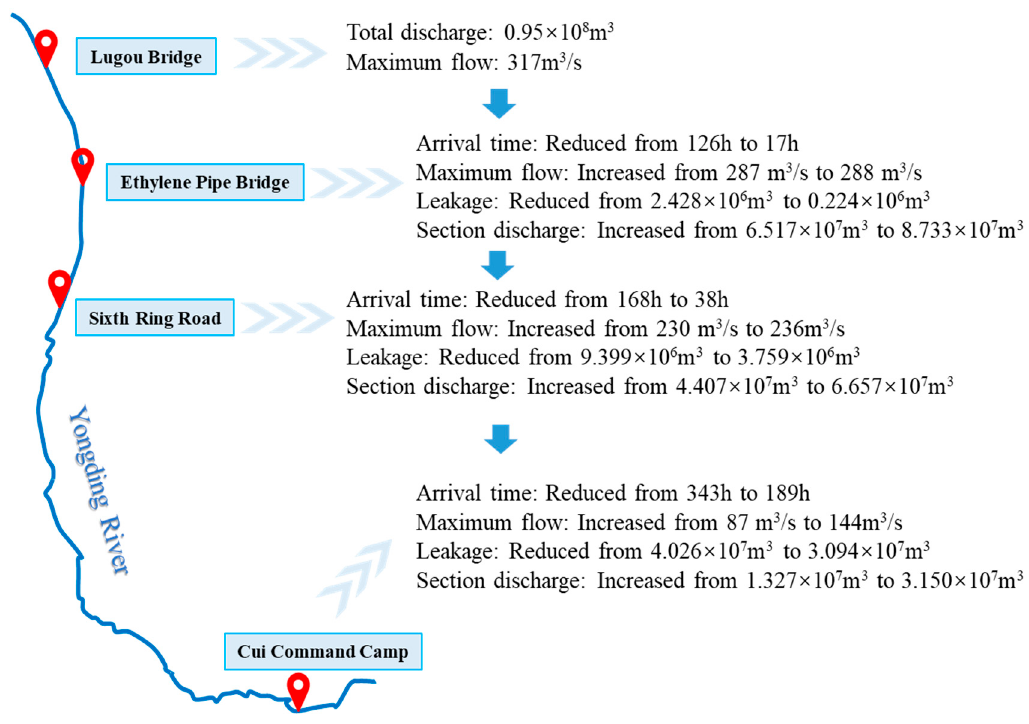
Figure 8. Comparison of water flow routing process before and after pothole repair.